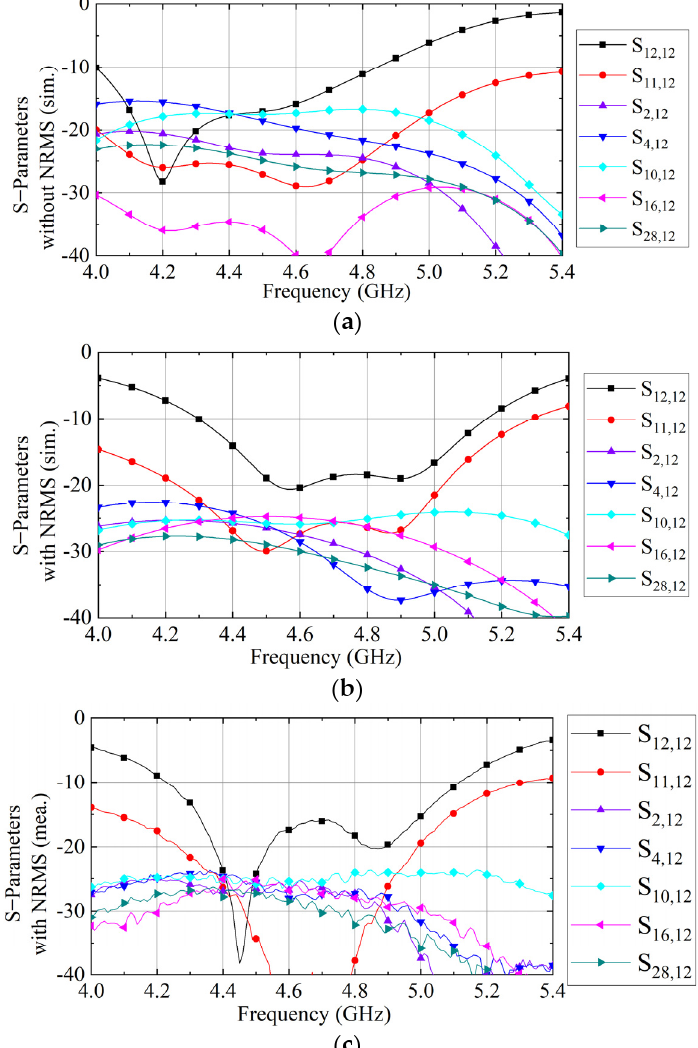
Figure 10. ( a ) S-parameters of arrays with and without NRMS, ( a ) the simulated S-parameters without NRMS, ( b ) the simulated S-parameters with NRMS, and ( c ) the measured S-parameters with NRMS.